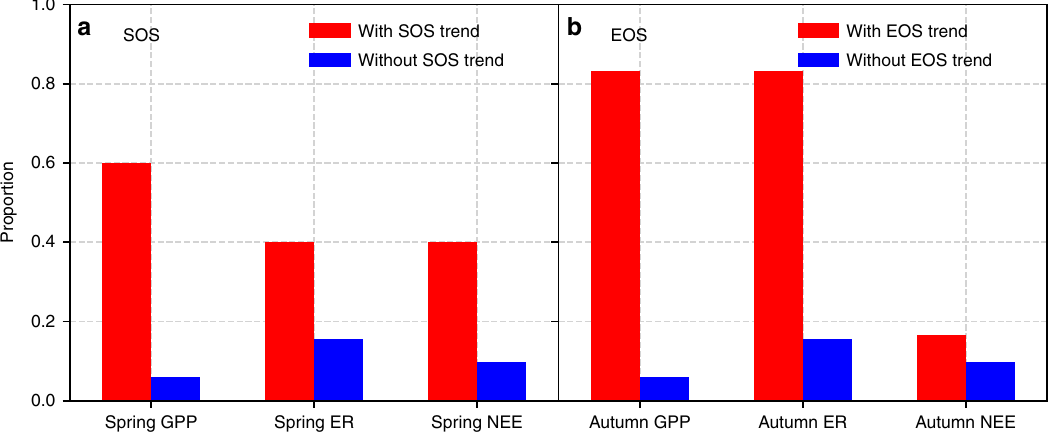
Fig. 5 Proportion of sites with signi fi cant carbon fl uxes trends among sites with and without SOS or EOS trends. In a , the red and blue bars stand for the proportion of sites with and without signi fi cant SOS trend, respectively; in b , the red and blue bars stand for the proportion of sites with and without signi fi cant EOS trend, respectively. SOS start of growing season, EOS end of growing